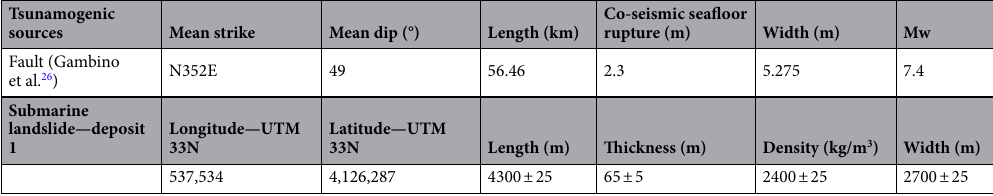
Table 4. Parameters of tsunamogenic sources used for GEOWAVE